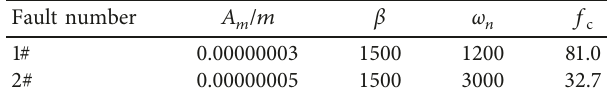
Figure 4: Procedure for optimal separated impulse signal based on